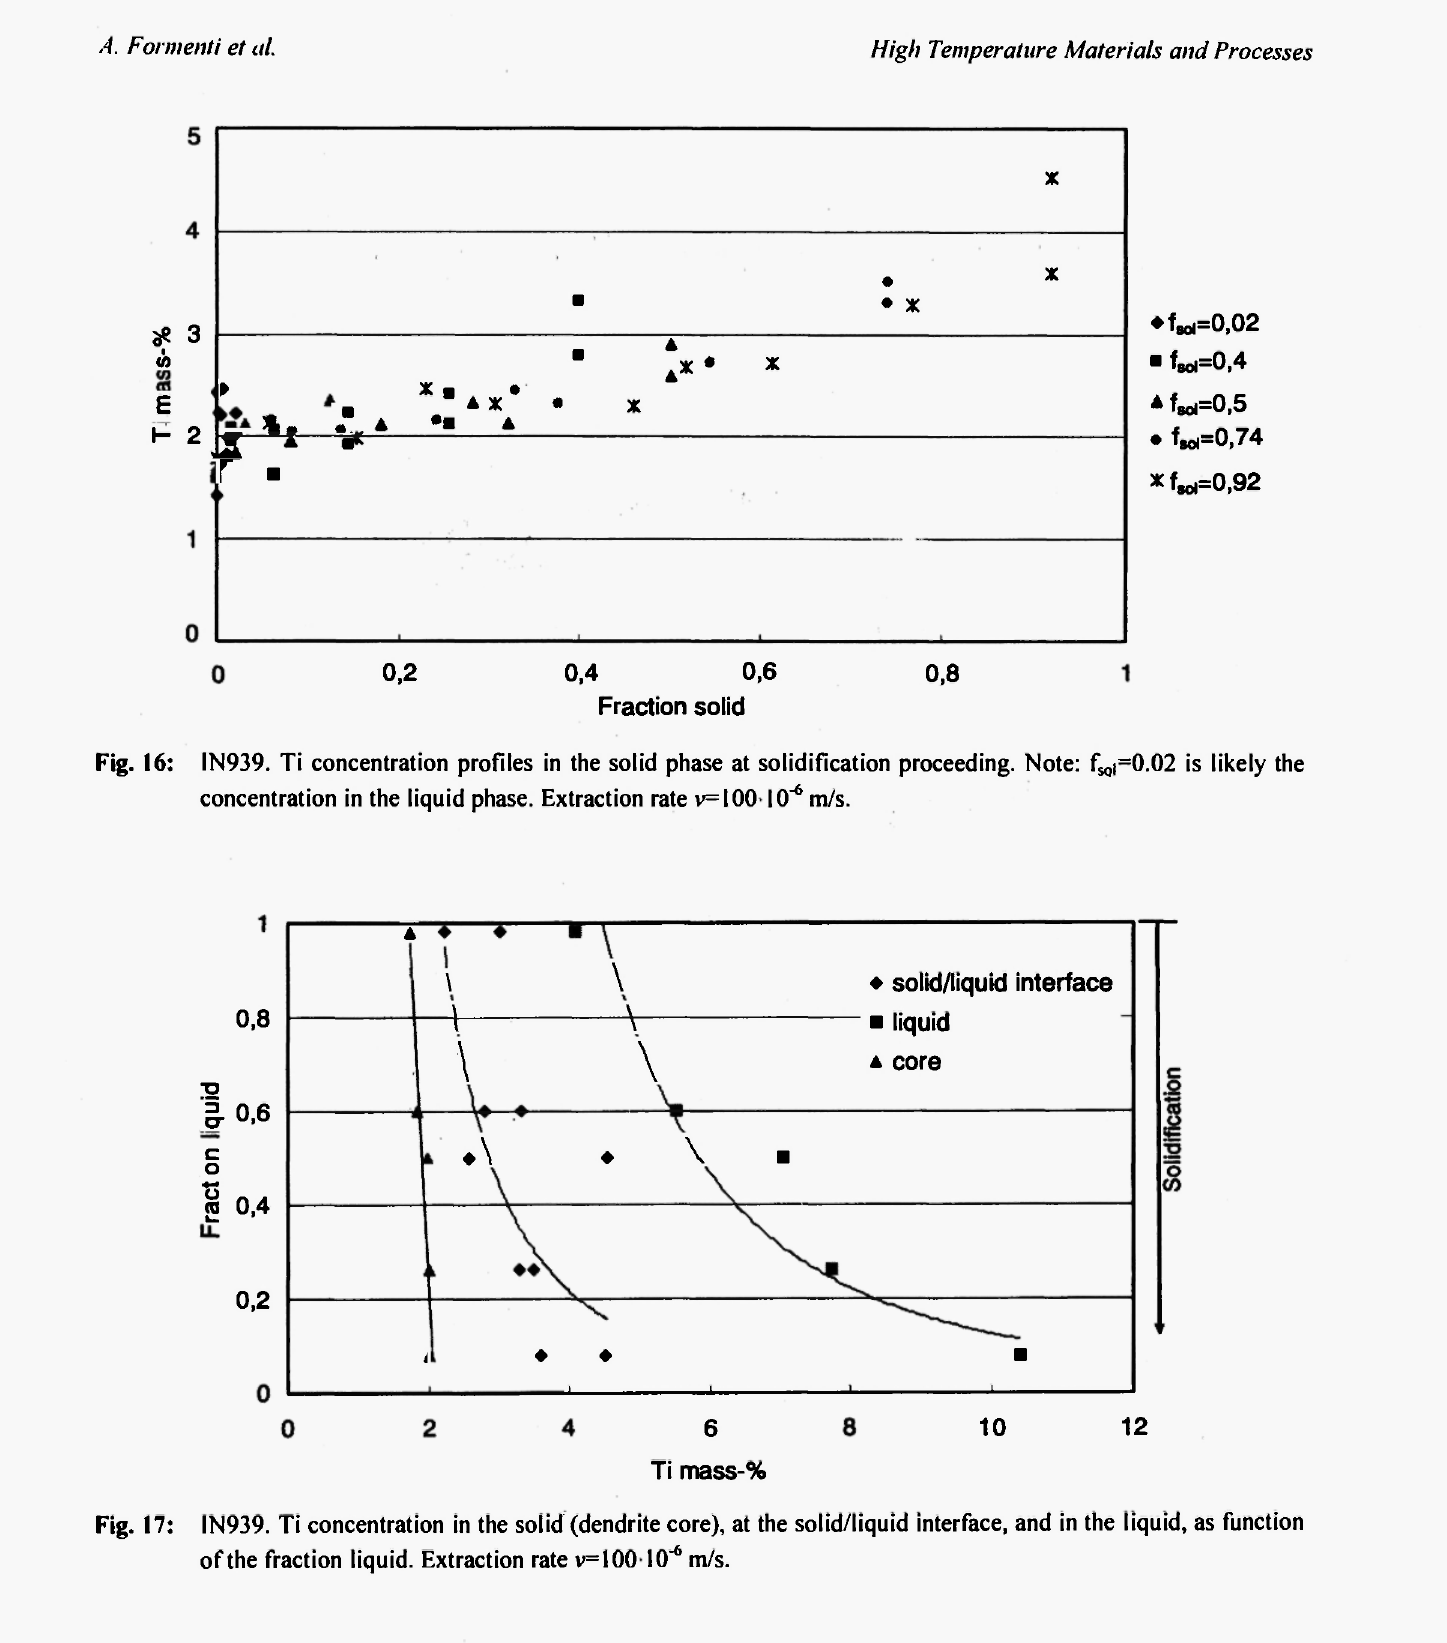
IN939. Ti concentration in the solid (dendrite core), at the solid/liquid interface, and in the liquid, as function of the fraction liquid. Extraction rate v=10010' 6